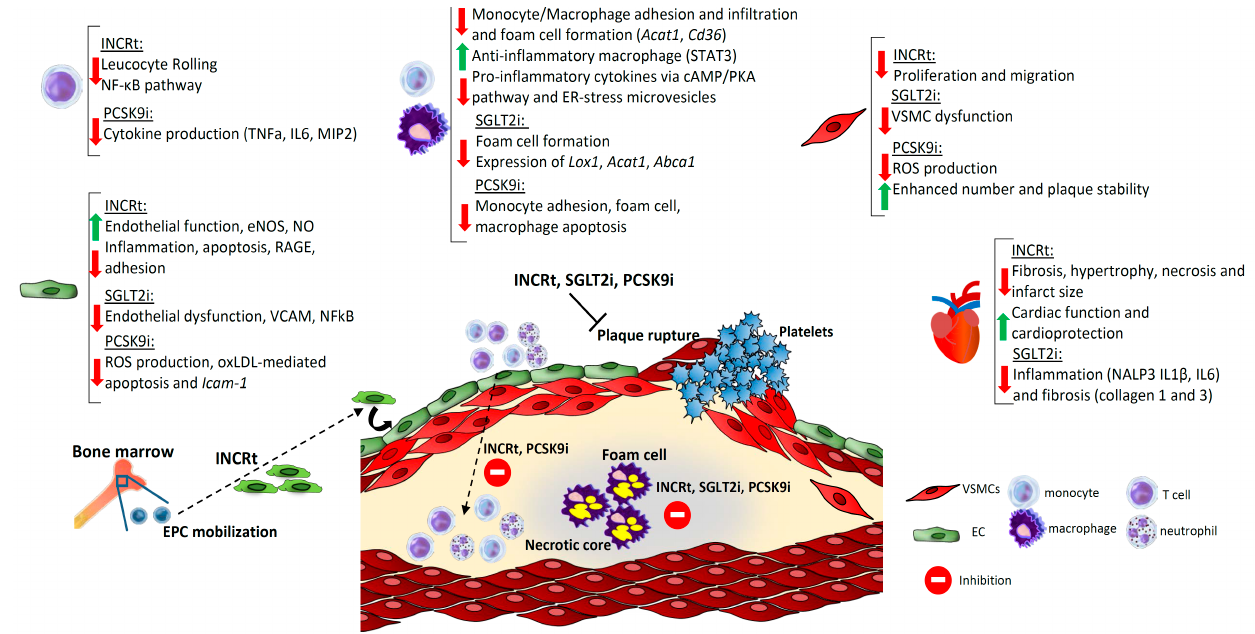
Figure 2. Common mechanism of action of incretin ‐ therapies, SGLT2i and PCSK9i in immune and vascular cells involved in atherosclerosis progression and in cardiomyocyte function. The main protective mechanisms of PCSK9i and INCRt in T cells include the impairment of leukocyte rolling and a decrease in NFkB activation and cytokine secretion. Both PCSK9i and INCRt also reduce monocyte adhesion and recruitment while in macrophages all three class drugs decrease macrophage foam cell formation. INCRt also decreases inflammatory genes in macrophages and PCSK9i impairs restrains proatherogenic apoptosis. Endothelial function is improved by all three class drugs by several mechanisms such as enhanced eNOS, reduced adhesion of leukocytes and inflammatory molecules and diminished ROS production. Notably, INCrt also promote endothelial cell repair by the mobilization of EPC from the bone marrow. In VSMCs’ INCRt decrease proliferation and hyperplasia, PCSK9i promotes plaque stability by enhancing VSMC number, and SGLT2i reduce their dysfunction. All these mechanisms lead to a decrease in leukocyte retention in the subendothelial space, less foam cell formation, reduced necrotic core and prevention of plaque rupture that, in patients, ensues the acute cardiovascular events. Lastly, among the actions observed in cardiomyocytes stands out the improved cardiac function by INCRt and SGLT2i by decreasing inflammation and fibrosis and necrosis. EPC: endothelial progenitor cell; INCRt: incretin ‐ therapies; SGLT2i: sodium ‐ glucose co ‐ transporter 2 inhibitor; PCSK9i: proprotein convertase subtilisin kexin 9 inhibitor.